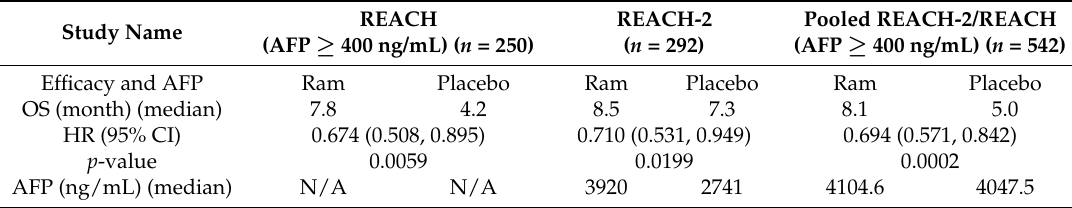
Table 4. Comparison between REACH (AFP ≥ 400 ng/mL), REACH-2, and pooled data. OS: overall survival; AFP: